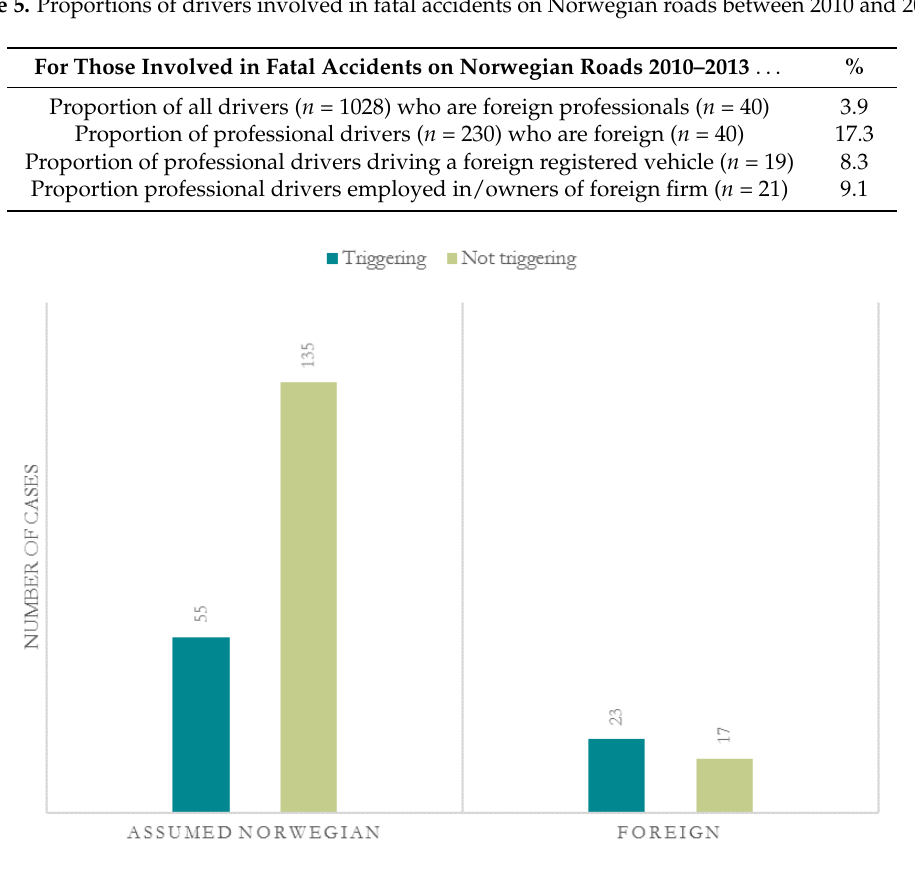
Figure 2. Number of Norwegian and foreign professional drivers involved in fatal accidents on Norwegian roads between 2010 and 2013 who drove a vehicle classified by AAG as